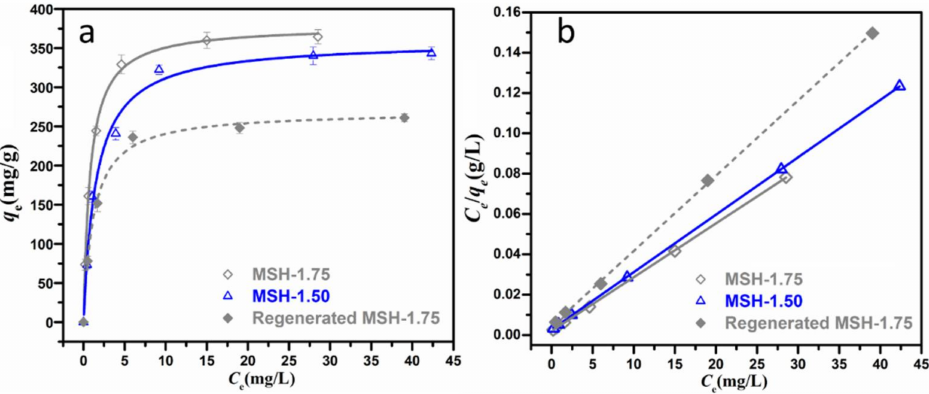
Figure 7. ( a ) Curve and ( b ) liner fitting of Langmuir isotherm for MB adsorption by MSH-1.50, MSH-1.75 and regenerated MSH-1.75 samples.